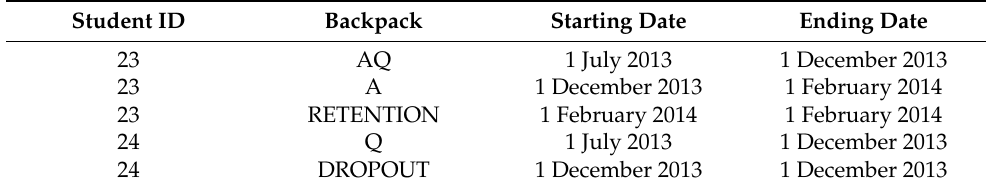
Table 1. Example of event log for